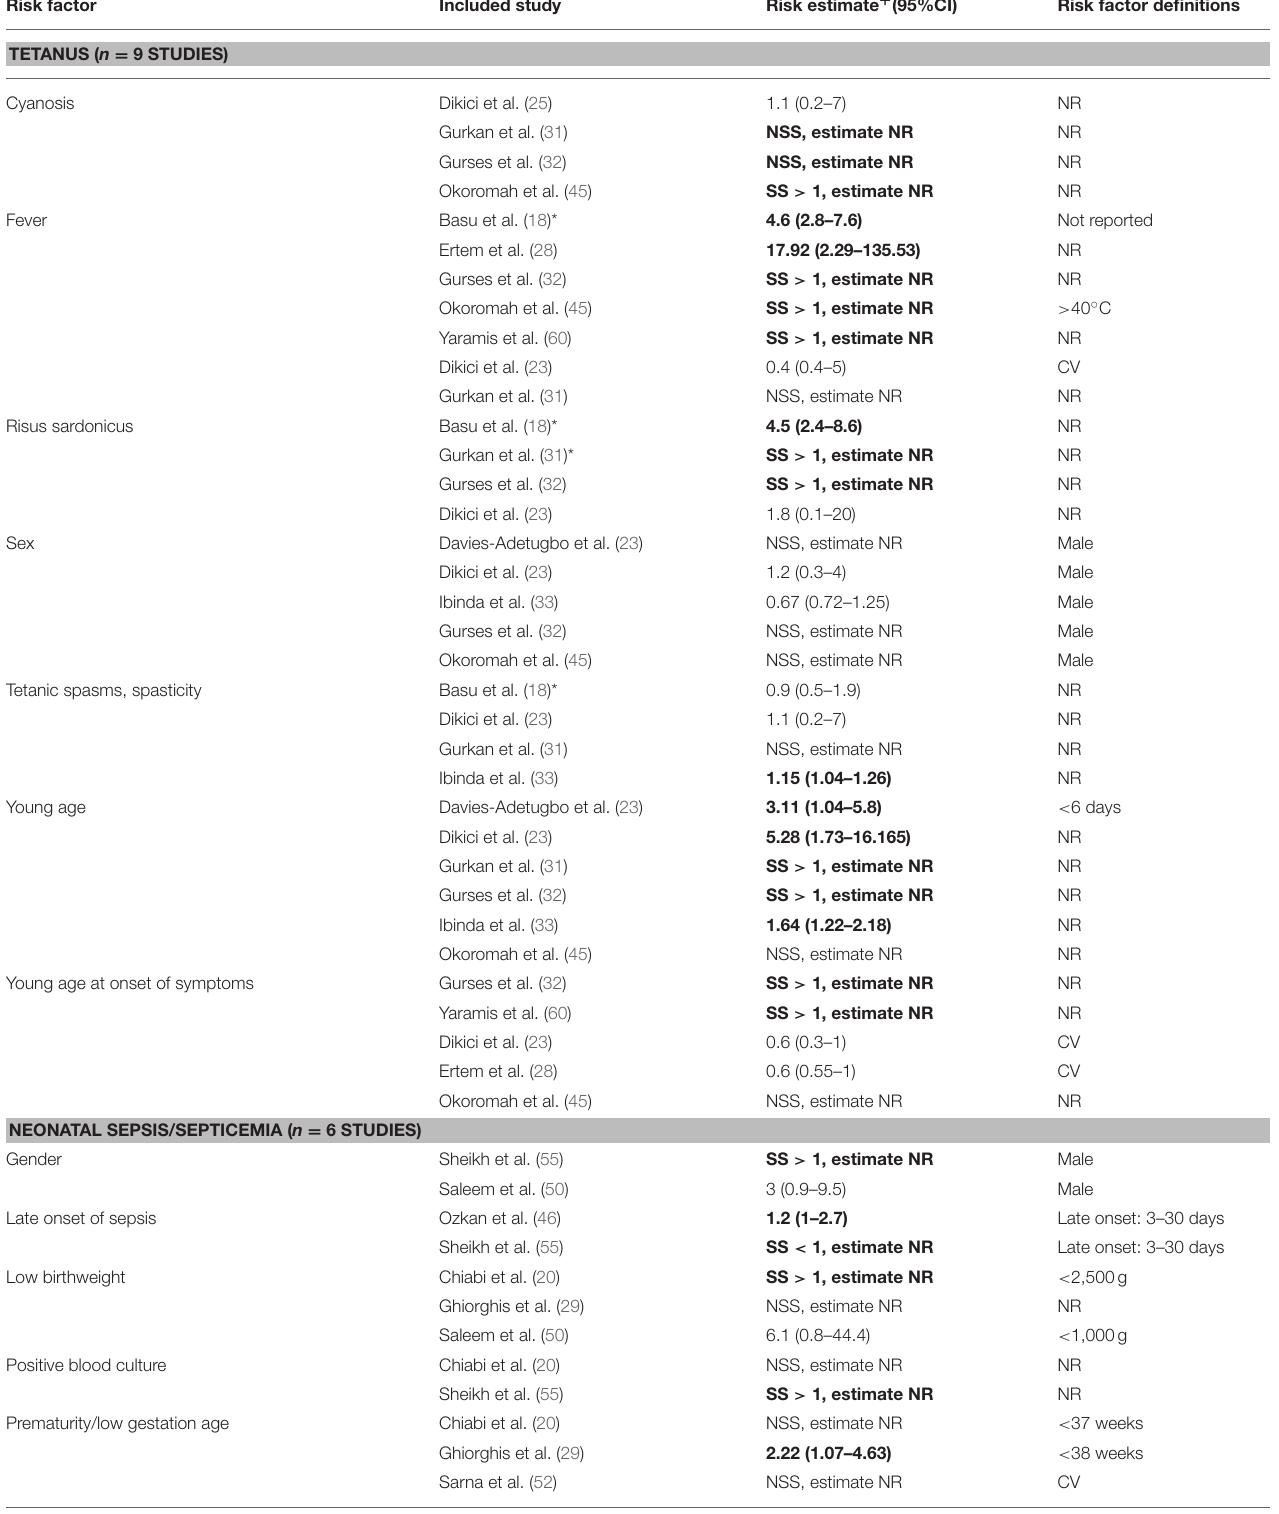
TABLE 3 | Summary of risk factors for neonatal mortality by underlying